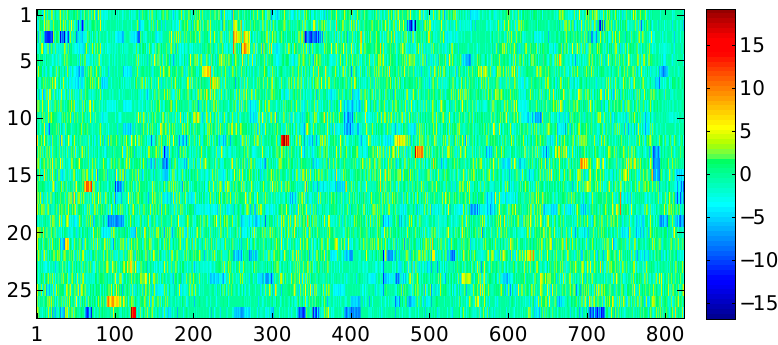
Figure 12. Radio map recovery error between the recovered one and the ideal one.